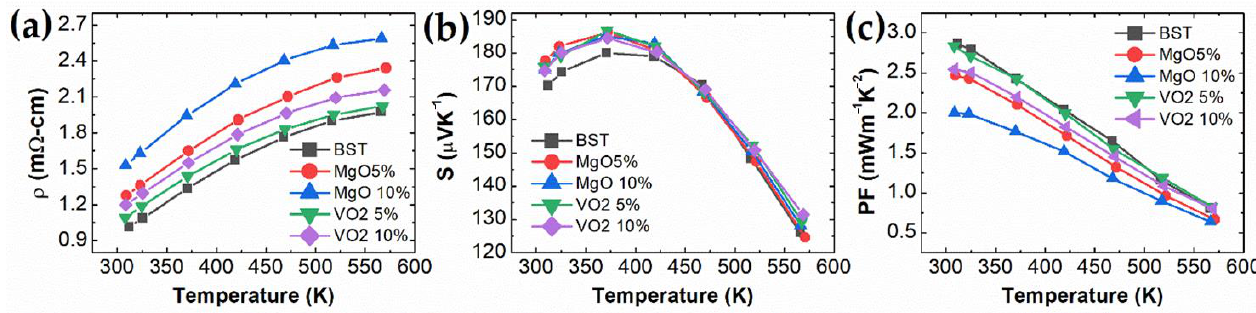
Figure 2. Temperature-dependent ( a ) electrical resistivity ρ ( T ) ; ( b ) Seebeck coefficient S ( T ) ; ( c ) power factor S 2 / ρ of MgO and VO 2 BST composites.